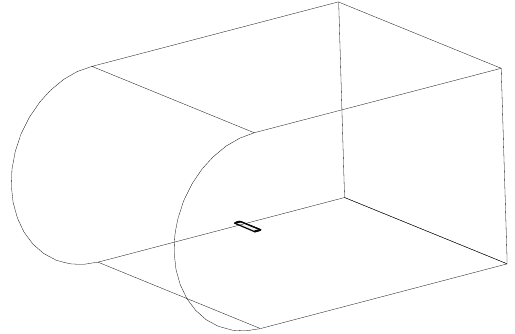
Figure 2: The boundaries of the solution